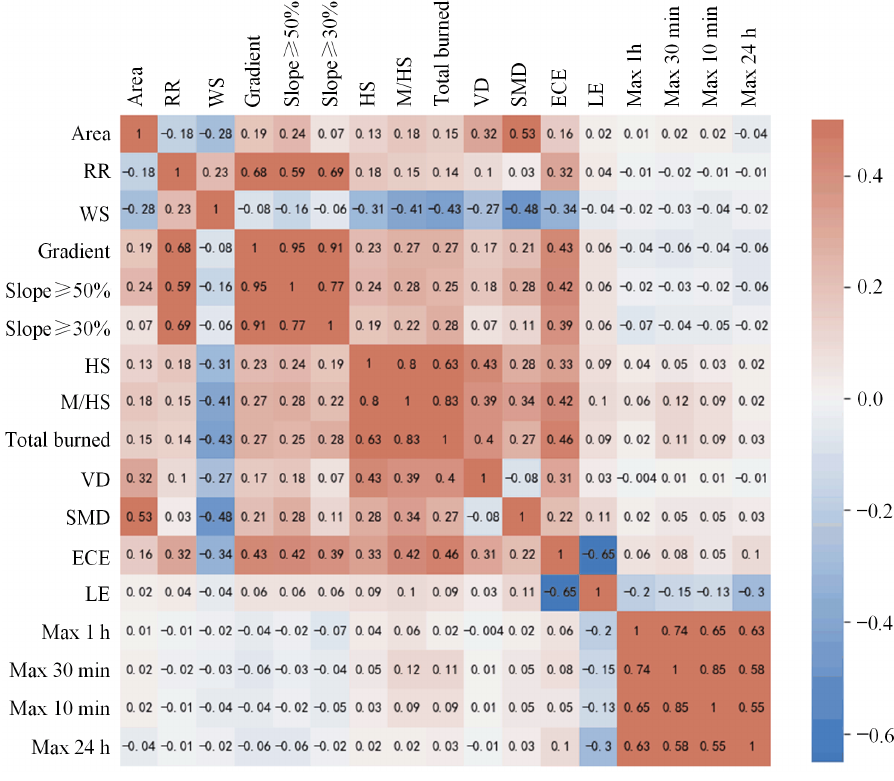
Figure 9. Pearson’s correlation coefficient results, where red represents positive correlation and blue represents negative correlation with increasing magnitude as each color darkens respectively.